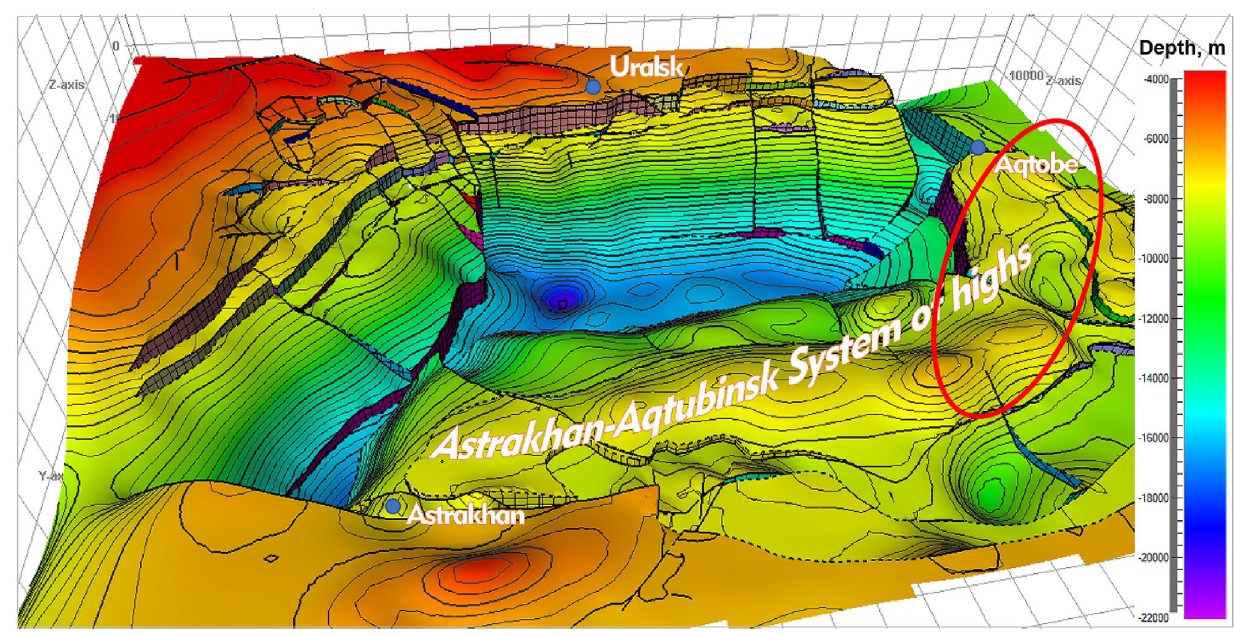
Fig. 2 Basement structural map of the Pre-Caspian sedimentary Basin (modified from Soloviev 1992; Ulmishek 2001; Volozh et al. 2003). The red circle showing area under the